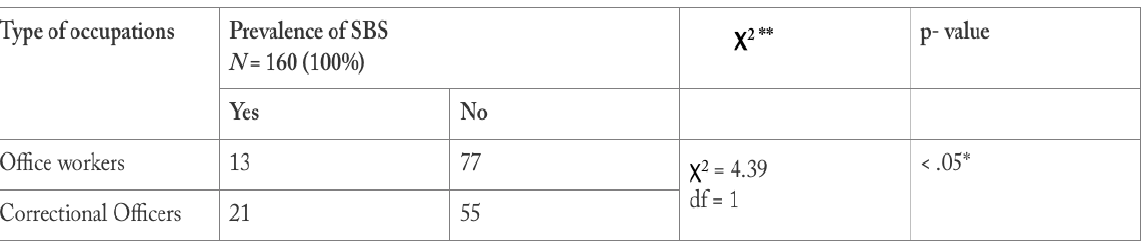
Table 3. Comparison of the prevalence of Sick Building Syndrome (SBS) between office workers ( n = 85) and correctional officers ( n = 76).